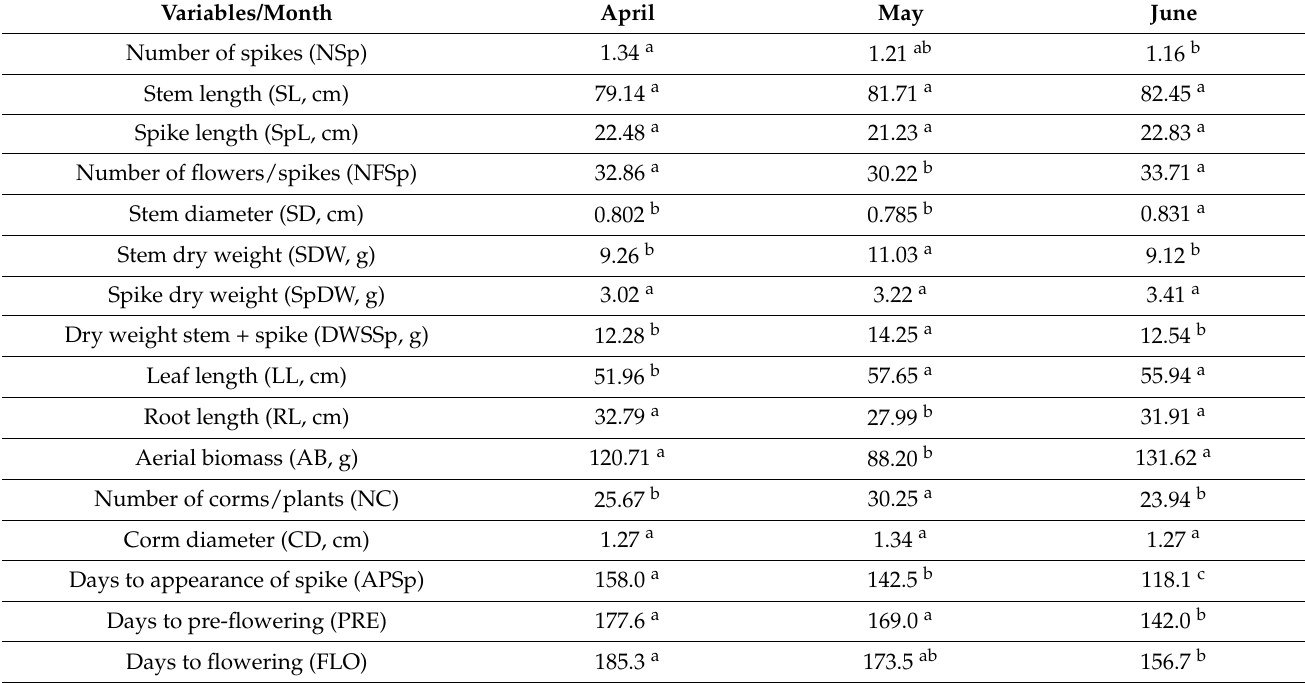
Table 3. Characteristics of spike and leaf stem and days to flowering of plants established on three dates in April, May, and